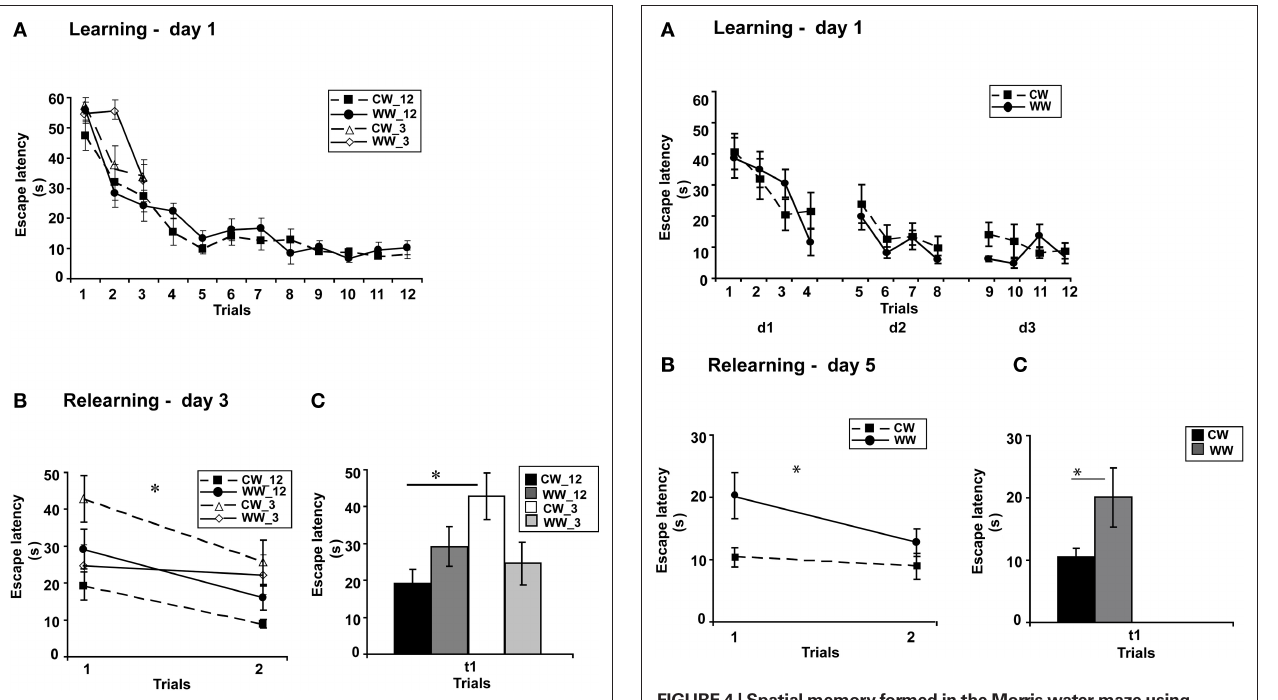
Figure 3 | Spatial memory formed in the Morris water maze under different stress conditions, with 3-trials versus 12-trials training. (A) Mean escape latencies for each of 12 or 3 initial training trials (day 1) did not differ between WW and CW animals; (B) Memory retention tested on day 3 (during relearning) of the animals trained for 3 trials was impaired as compared to that of the animals trained for 12 trials in CW, but not in WW animals; (C) The mean escape latency of the cold water animals trained for 3 trials during the first trail was significantly longer than that of the cold water group trained for 12 trials (* p < 0.05). (CW_12, Cold Water 12-trials training; WW_12, Warm Water 12-trials training; CW_3, Cold Water 3-trials training; WW_3, Warm Water 3-trials training).